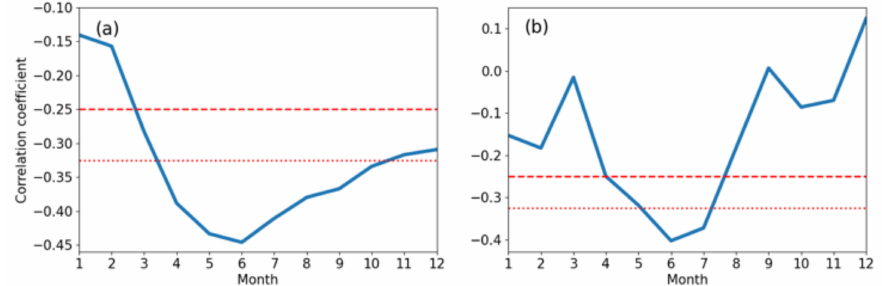
Figure 8. ( a ) Lead–lag correlations of the interannual components of anomalous SST indexes identified in the Niño3.4 region with the interannual components of the PC1 for the period of 1960 to 2018. ( b ) As in ( a ), but for western Pacific warm pool (16 ◦ –18 ◦ N, 141 ◦ –149 ◦ E) and PC2. The red dotted-long and dotted lines, respectively, represent the 95% and 99% confidence level.